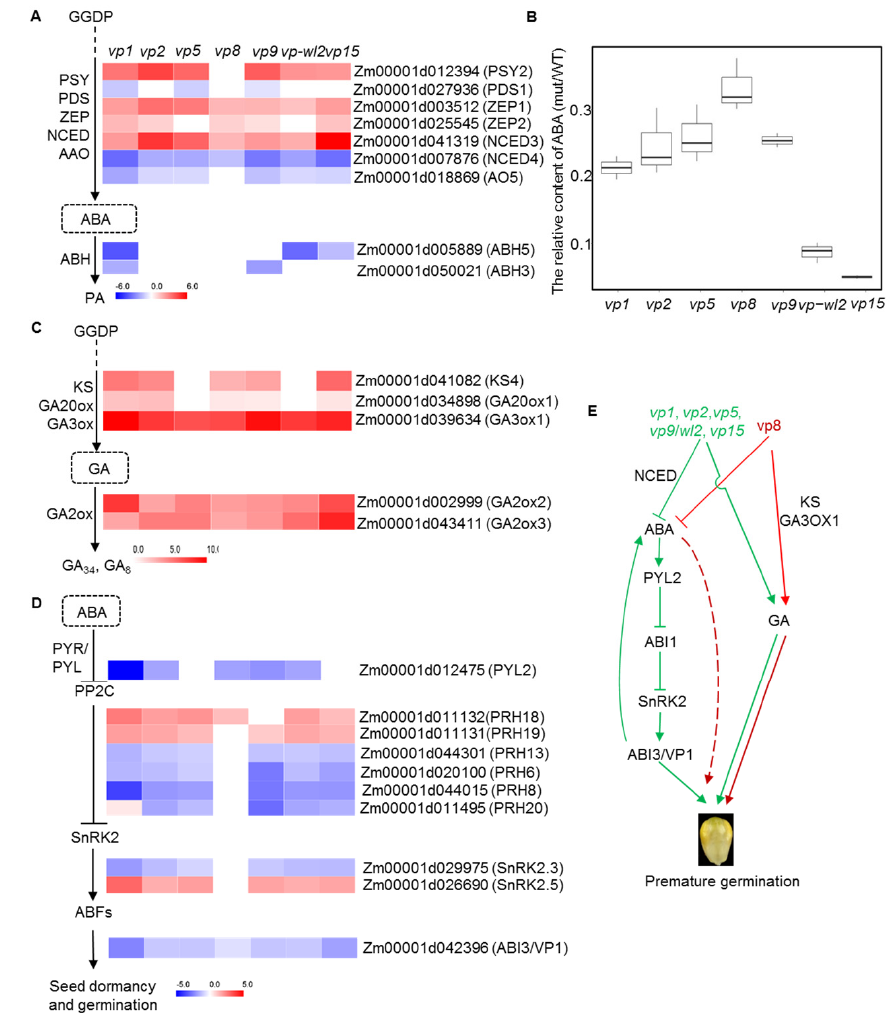
Figure 4. Vivipary mutants affected the biosynthesis and signaling of ABA and GA. ( A ) The expression profiles of ABA biosynthesis-related genes, indicated by log 2 (fold change) of gene expression in mutants versus wild types, are color-coded. Red boxes represent upregulated genes, and blue boxes represent downregulated genes. ( B ) The relative ABA content of viviparous mutant and wild-type seeds at 30 DAP. Three biological replicates of each sample were conducted. ( C ) The expression profiles of GA biosynthesis-related genes, indicated by log 2 (fold change) of gene expression in mutants versus wild types, are color-coded. Red boxes represent upregulated genes, and blue boxes represent downregulated genes. ( D ) The expression profiles of ABA signaling-related genes, indicated by log 2 (fold change) of gene expression in mutants versus wild types, are color-coded. Red boxes represent upregulated genes, and blue boxes represent downregulated genes. ( E ) The pathway of seven vivipary mutants regulated precocious seed germination. Green lines represent the pathway of vp1 , vp2 , vp5 , vp9 / wl2 , and vp15 , and red lines represent the pathway of vp8 .